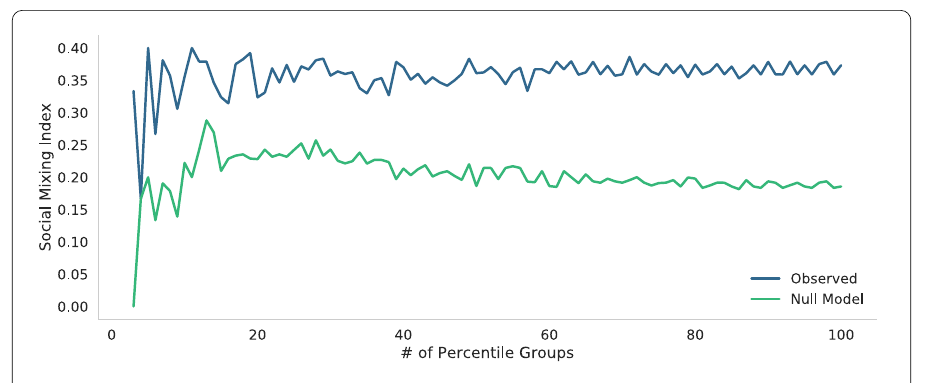
Figure 6 Comparison between the observed social mixing index (above) and the social mixing index in the null model (below). The curves represent how social mixing varies according to the number of categories (percentiles) used in the model [11]